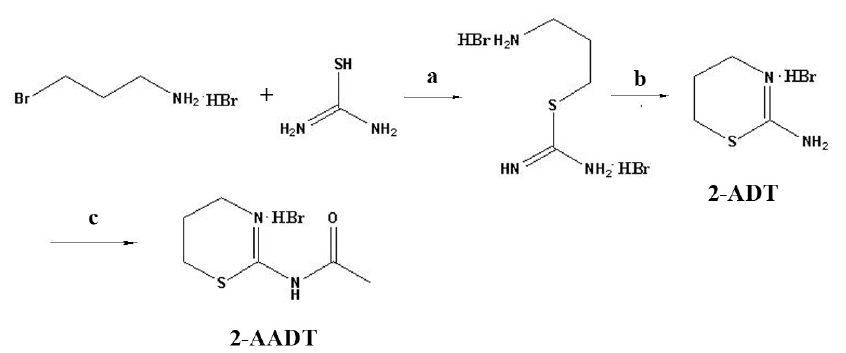
Figure 8. Reagents and conditions: (a) (CH 3 ) 2 CHOH, 82 ◦ C, 1.5 h; (b) H 2 O, 100 ◦ C, 21 h; (c) (CH 3 CO) 2 O, 90 ◦ C, 10.5